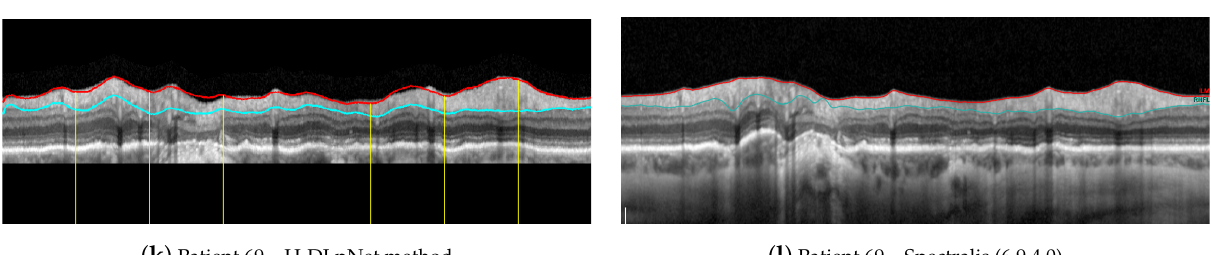
Figure 15. Segmentation results for the right eye of ( a – d ) patient 2, ( e – h ) patient 20, and ( i – l ) patient